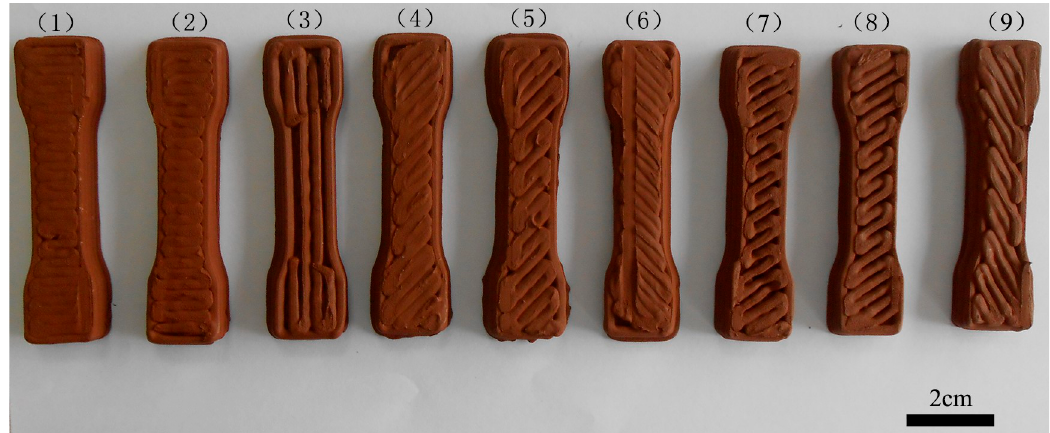
Figure 7. Green samples with different printing parameters corresponding to the data of Table 6.